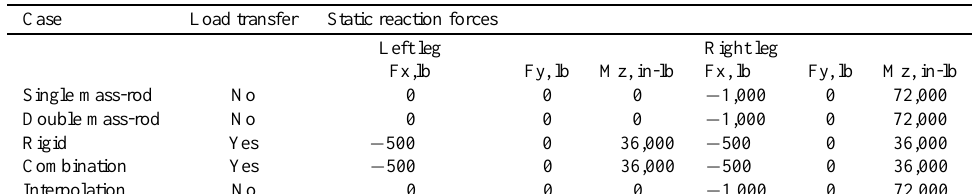
Table 1 Summary of static analysis results